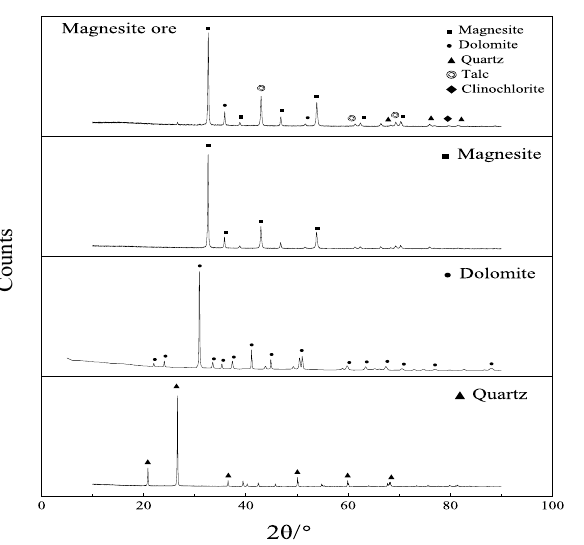
Figure 1. XRD pattern of